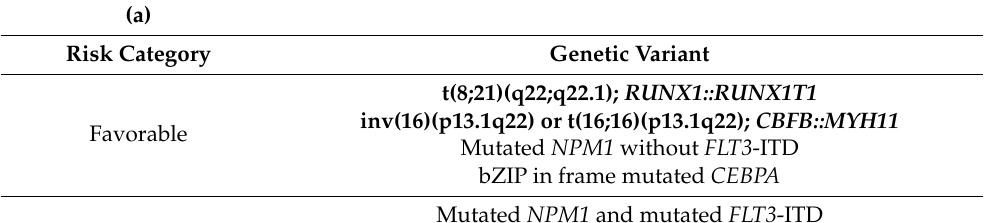
Table 1. (a): 2022 version of the European Leukemia Net risk stratification of AML [1]. Structural variants detectable by OGM are presented in bold. bZIP: Basic Leucine Zipper Domain. (b): Addi- tional structural aberrations that are not part of ELN risk classification but are recurrent according to International Consensus Classification 2022, all of which are all detectable by OGM and, therefore, presented in